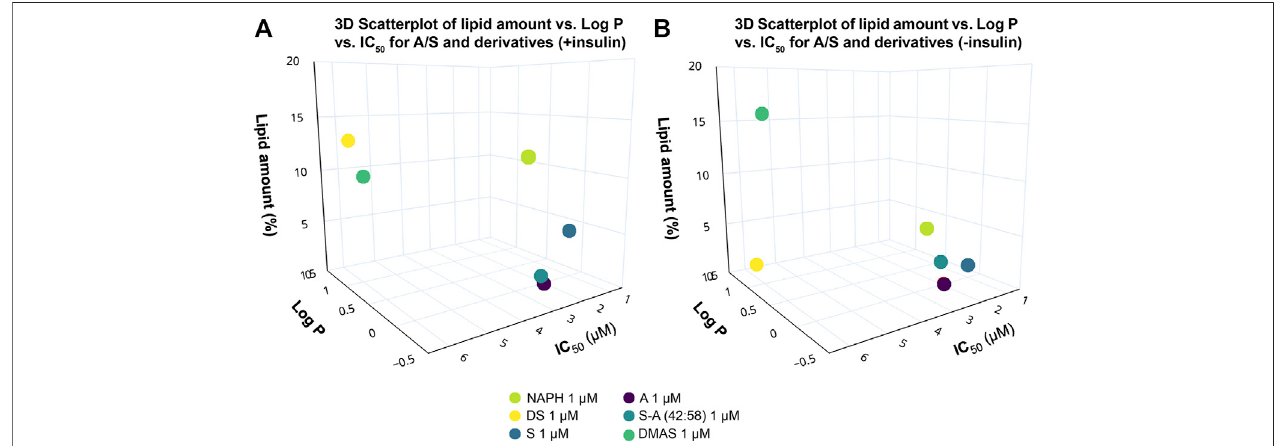
FIGURE 6 | 3D scatterplots showing the correlation between lipid amount in 3T3-L1 cells treated with A/S and derivatives [NAPH, DS, S-A (42:58), DMAS; 1 μ M], Log p and IC 50 values of the A/S compounds in the (A) presence and (B) absence of insulin. Compounds bearing the OH group in the side chain [S, A and S-A (42:58)] exhibited a stronger inhibition of lipid formation, in the absence of insulin, enhancing the anti-adipogenic activity. The 3D scatterplots were generated using Plot. ly Chart Studio (available at https://chartstudio.plot.ly; Plotly Technologies Inc., 2022).